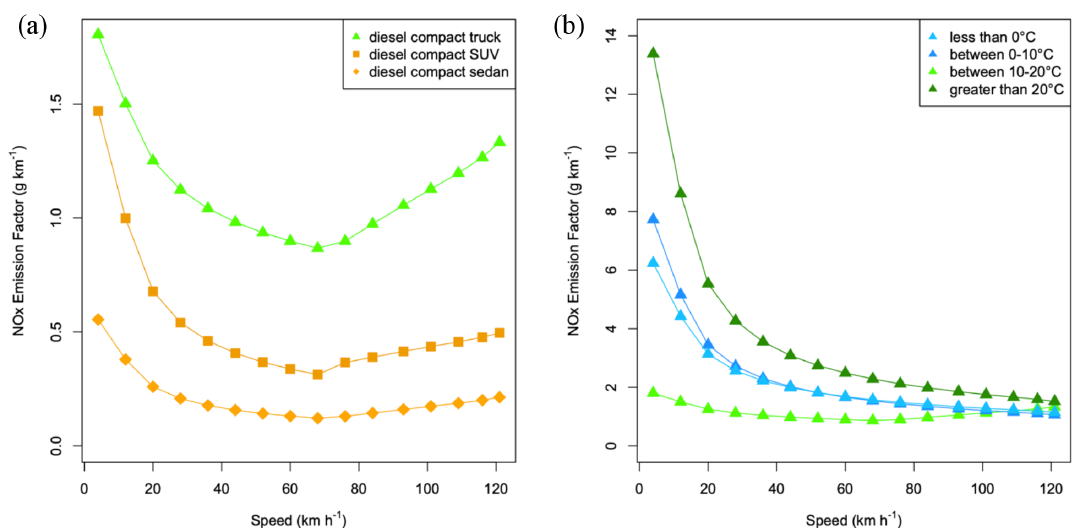
Figure 3. Variation of NO x emission factors from diesel compact engines by vehicle speed and ambient temperatures: (a) NO x emission factors in relation to vehicle speed and (b) NO x emission factors of diesel compact trucks in relation to both vehicle speed and ambient temperature.